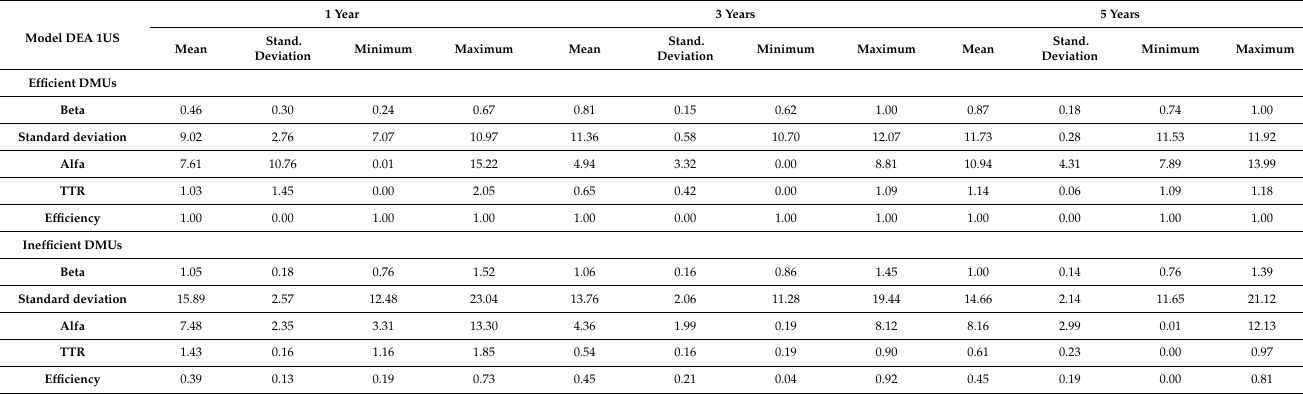
Table A13. Descriptive statistics of efficient and inefficient DMUs (US.